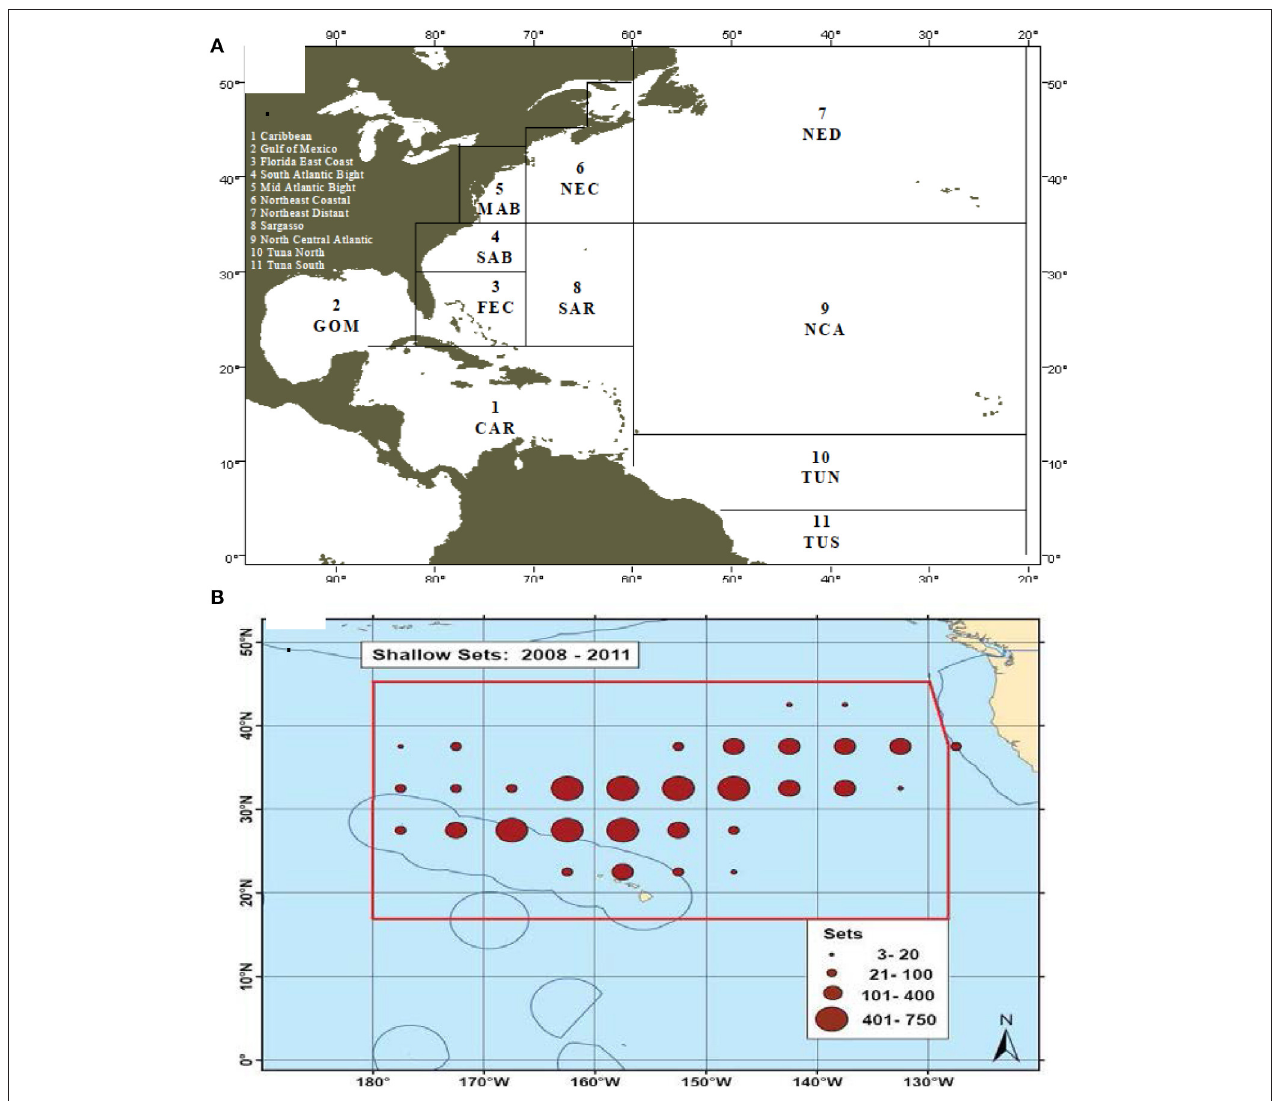
FIGURE 1 | United States (A) . Atlantic pelagic longline fisheries statistical reporting areas as recorded by NOAA NMFS Southeast Fisheries Science Center. CAR, Caribbean; GOM, Gulf of Mexico; FEC, Florida East Coast; MAB, Mid-Atlantic Bight; NCA, North Central Atlantic; NEC, Northeast Coastal; NED, Northeast